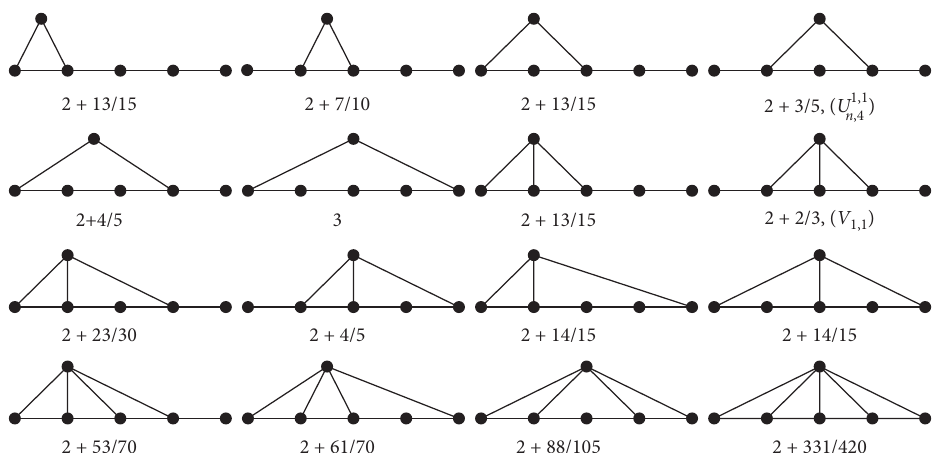
Figure 4: Quasi-tree graphs of order 6 obtained from P